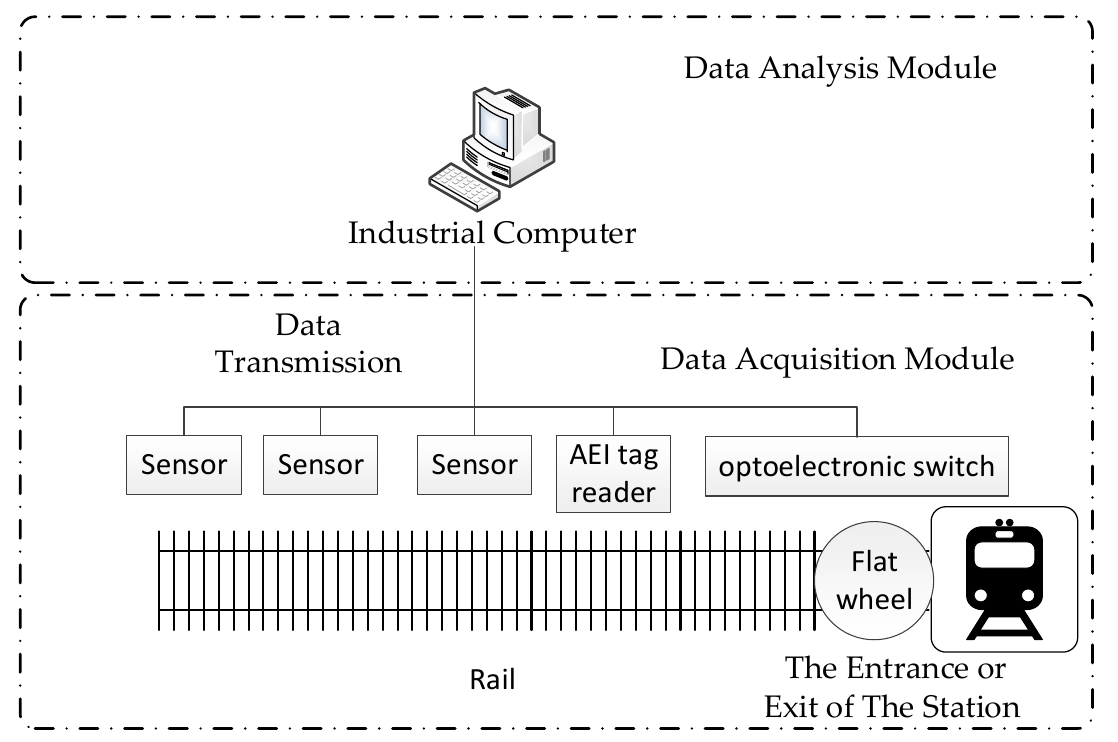
Figure 3. Wayside in-service fl at detection system schematic.